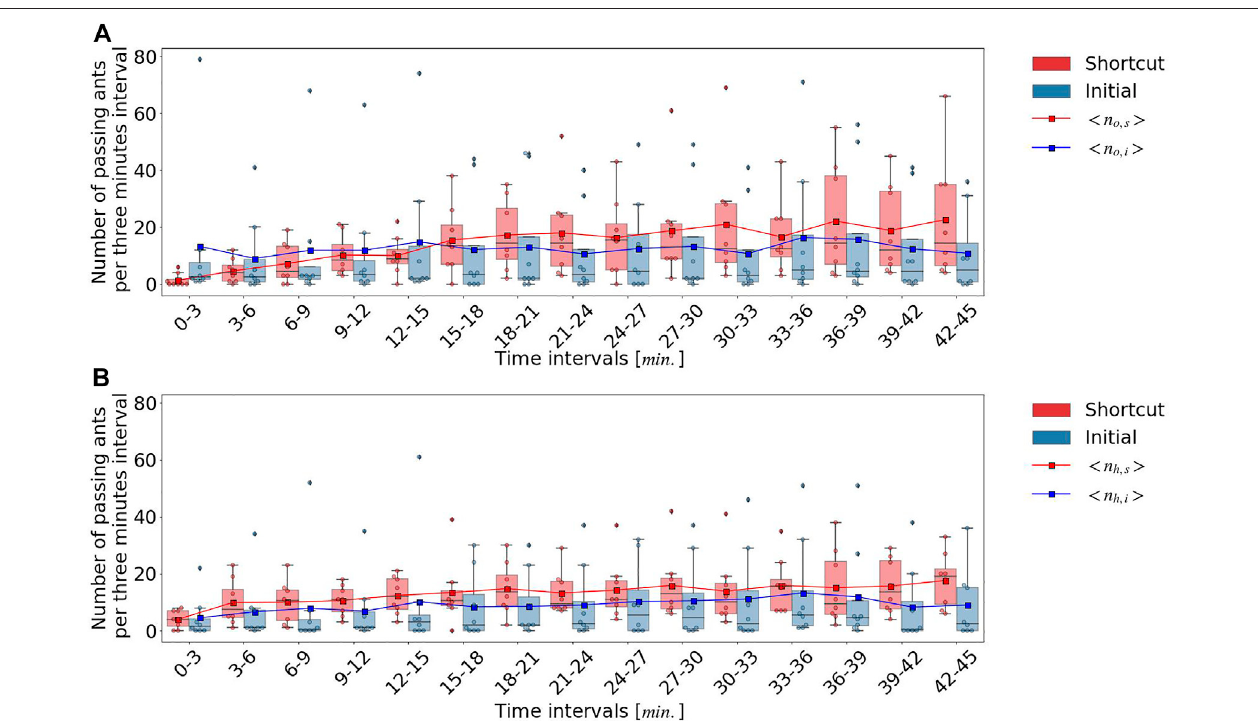
FIGURE 4 | Number of ants passing each decision line per 3 min interval: (A) outward ants. (B) homeward ants.